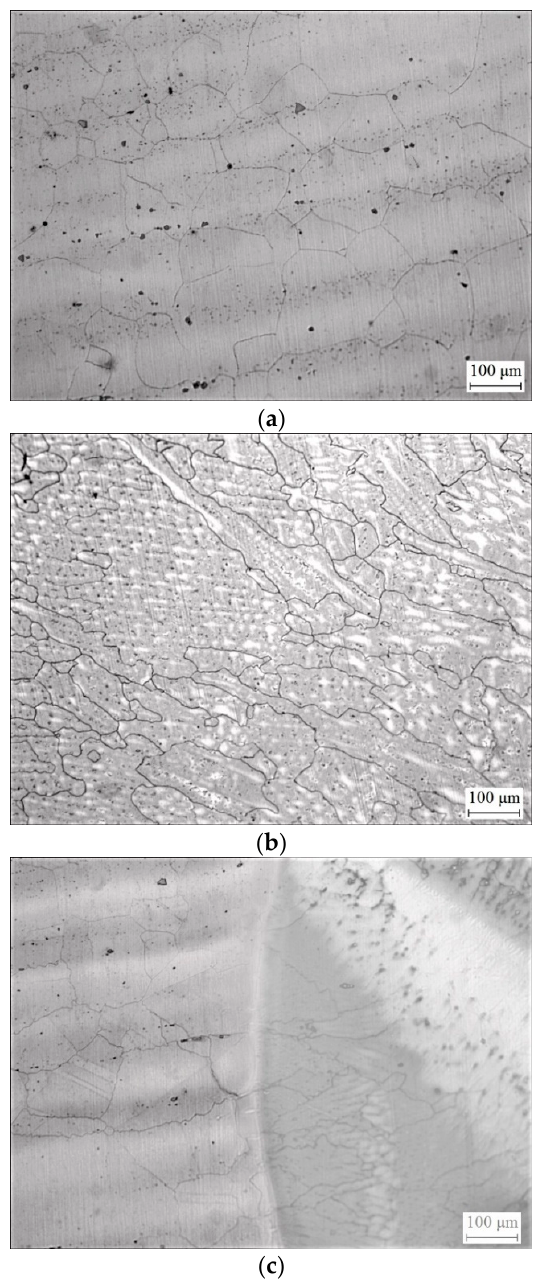
Figure 2. Optical micrographs of ( a ) base metal (BM); ( b ) weld; and ( c ) heat affected zone (HAZ).